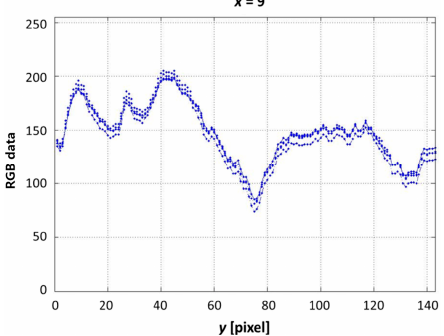
Figure 2. Red, Green and Blue ( RGB ) data of image file of wood pellet (Figure 1) along y pixel at x = 9.